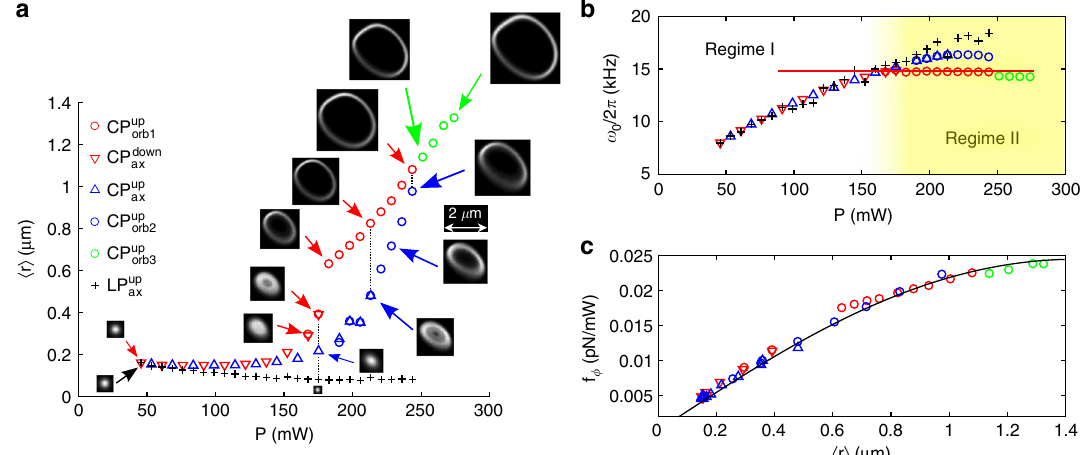
Fig. 3 Graphical comparison of the key physical quantities in regimes I and II. a Mean value of the orbit radius, 〈 r o 〉 , as a function of optical power. The insets show the probability density of the particle positions in the lateral xy plane relative to the given scale bar. Data related to circularly polarized beams (CP) are denoted by ◯ , Δ , and ∇ for the orbiting regime II. Δ and ∇ symbols correspond to increasing and decreasing optical power, respectively. For comparison data corresponding to parallel linear polarization (LP) are marked by black + signs. The sequence in which the data was acquired is indicated by colors and markers: red circles, red triangles, blue triangles, blue circles, + , and green circles. Overlapping points red circles with red triangle and blue triangles with blue circles illustrate how different calculation methods, used for regime I and II, overlap in the region where the orbiting is not fully developed. b Resonant trap frequency ω 0 /2 π or orbiting frequency Ω o /2 π for regime I or II, respectively. The theoretical value from Eq. (7b), is indicated by the horizontal red line. Measured values of ξ / m , and calculated values of f r / f ϕ have been used. c Spin force, f ϕ , for a particle of radius 770nm and density 2200 kg m − 3 . The presented values were determined as the mean value for x and y directions from fi ts to the PSD (Supplementary Note 3) for regime I and from the orbiting equation (Eq. 7b) for regime II (see details in Supplementary Note 5). The black curve shows the theoretical force, obtained from generalized Lorentz Mie theory (Supplementary Note 2). A single scaling parameter has been used (Supplementary Note